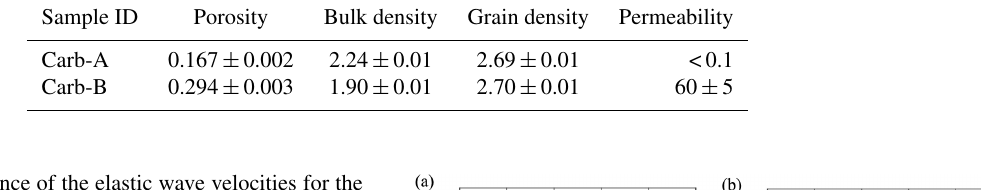
Table 2. Pressure dependence of the elastic wave velocities for the two studied samples. Pressure is in megapascal, and P - and S -wave velocity are in kilometres per second. Values are from Vialle et al. (2013).